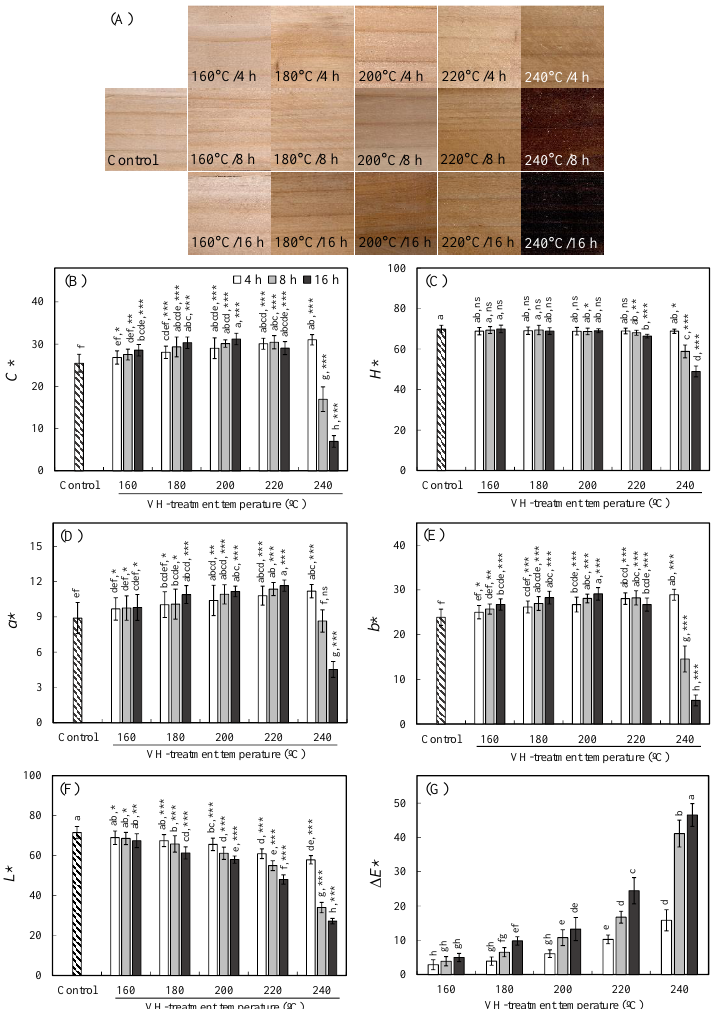
Figure 2. Surface images ( A ), C * ( B ), H * ( C ), a * ( D ), b * ( E ), L * ( F ), and Δ E * ( G ) of untreated and VH-treated luanta fir wood. Values are mean ± SD ( n = 15). Bars with different letters indicate significant differences ( p < 0.05). ns: non-significant; *: p < 0.05; **: p < 0.01; ***: p < 0.001 (one-tailed test) compared with control.